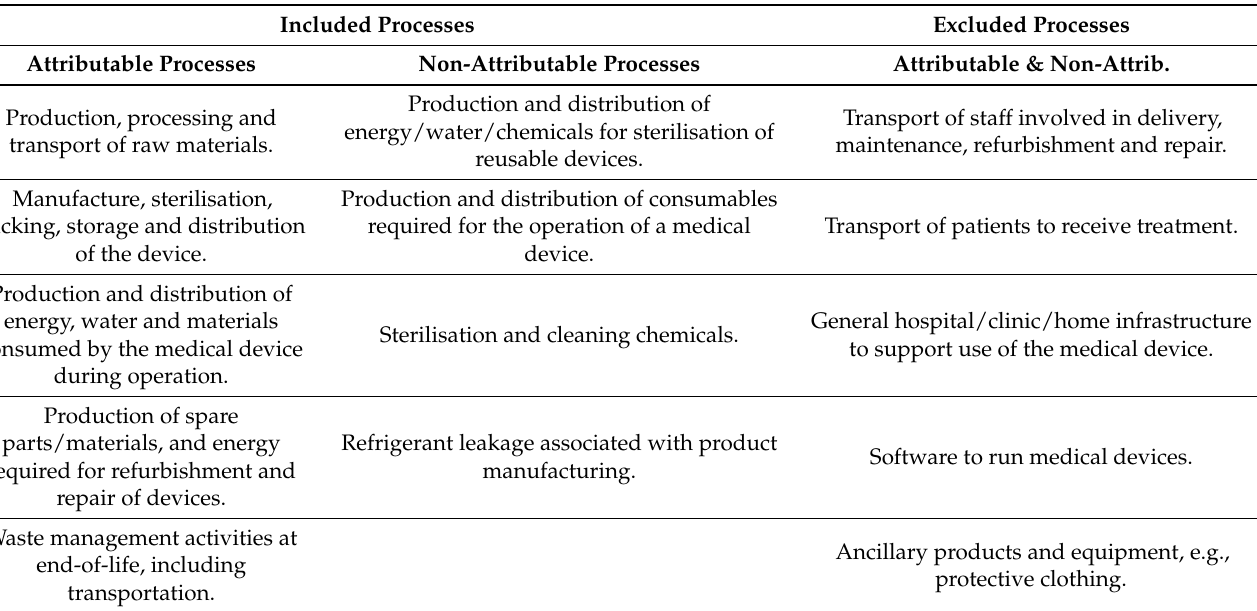
Table 1. Details of the individual life stages and material inputs are described in Section 3. Table 1. Quantitative rubric of the relevant material inputs and outputs for medical device LCA models. Taken from the NHS guideline for accounting and reporting medical device life cycles